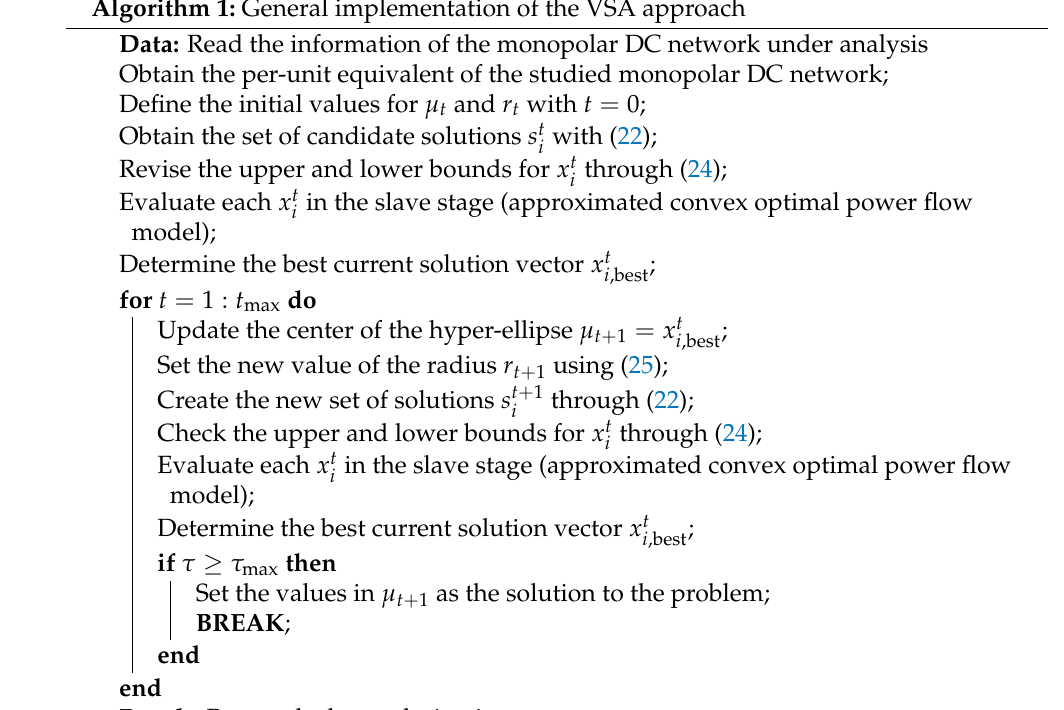
Algorithm 1: General implementation of the VSA